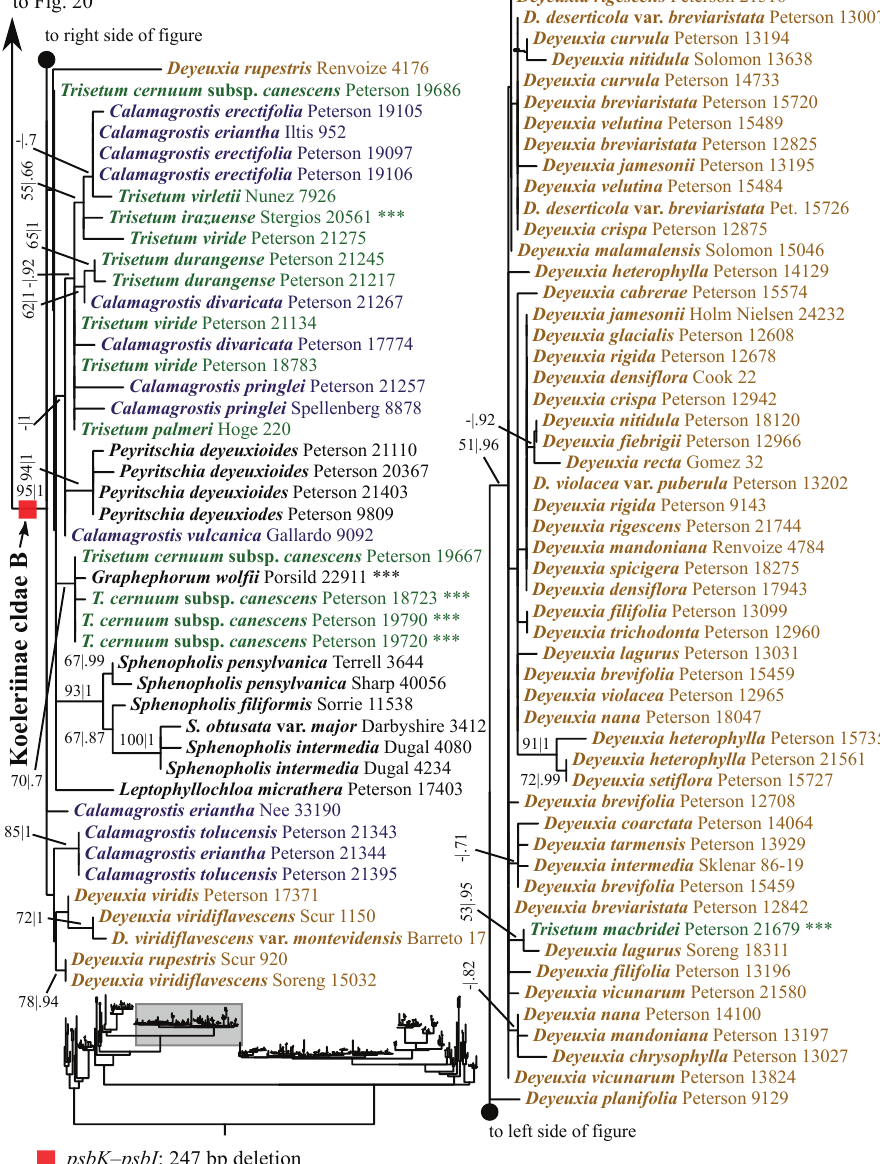
Figure 21. A portion (Koeleriinae clade B) of the maximum likelihood phylogram inferred from com- bined plastid data ( atpF–atpH , psbK–psbI , psbA–rps19–trnH , matK , trnL–trnF ). ML bootstrap support (left) and BI poster probabilities (right) are recorded along branches. A dash indicates bootstrap support <50%. No support is shown for branches with bootstrap support <50% and posterior probability <.5. The shaded area of the smaller tree on the bottom left indicates the location in the overall tree of the portion shown. Placements of samples with asterisks (***) are incongruent in nrDNA and plastid trees. An indel in psbK–psbI is mapped onto the